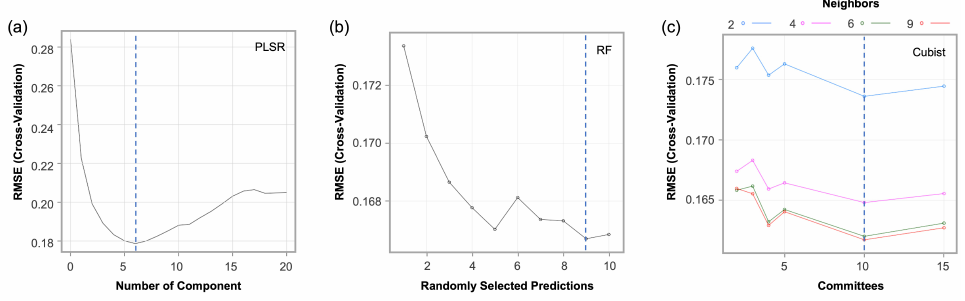
Figure 3. Root mean-square errors (RMSE) of cross-validation for soil EC, showing the best number of component, predictors and committees to use in each of the PLSR ( a ), RF ( b ), and C UBIST ( c ) models. As shown in Figure 4, all the three models successfully estimated the soil EC value.